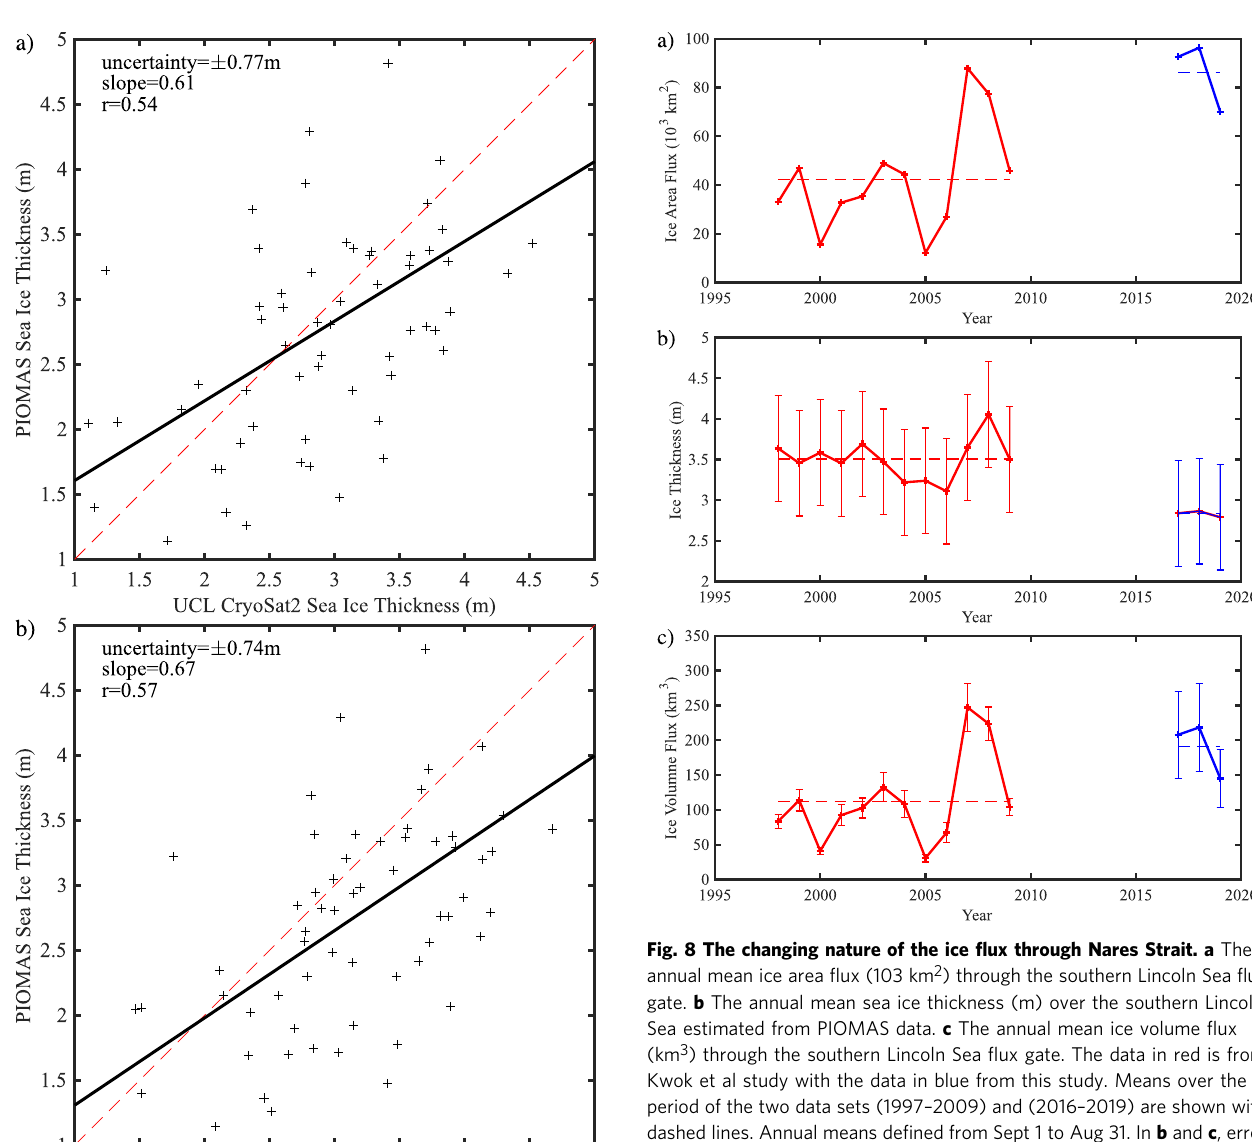
retrievals, AWI CryoSat2 29 , and UCL CryoSat2 30 , against the monthly mean PIOMAS sea ice thickness data for a representa- tive area of the Lincoln Sea shown in Fig. 1. The agreement between PIOMAS and the retrievals is consistent with previous work 12,25,28 .